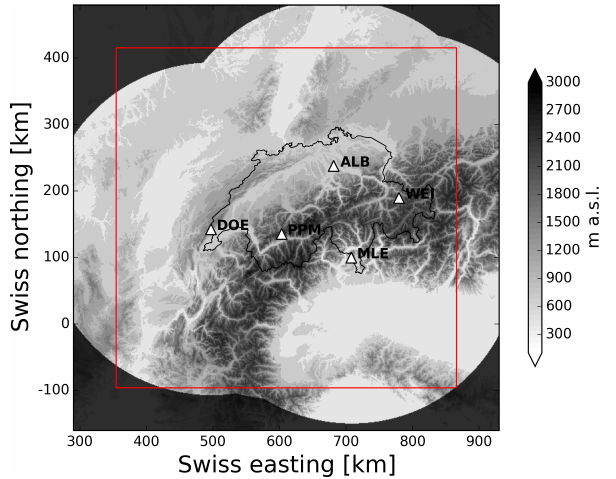
Figure 7. The 512km × 512km study domain (red box) plotted over the Alpine orography, the Swiss national borders and the radar composite mask. Locations of the 4th generation operational Me- teoSwiss weather radars are reported as white triangles. ALB: Al- bis (925ma.s.l.); DOE: La Dôle (1675ma.s.l.); MLE: Monte Lema (1625ma.s.l.); PPM: Pointe de la Plaine Morte